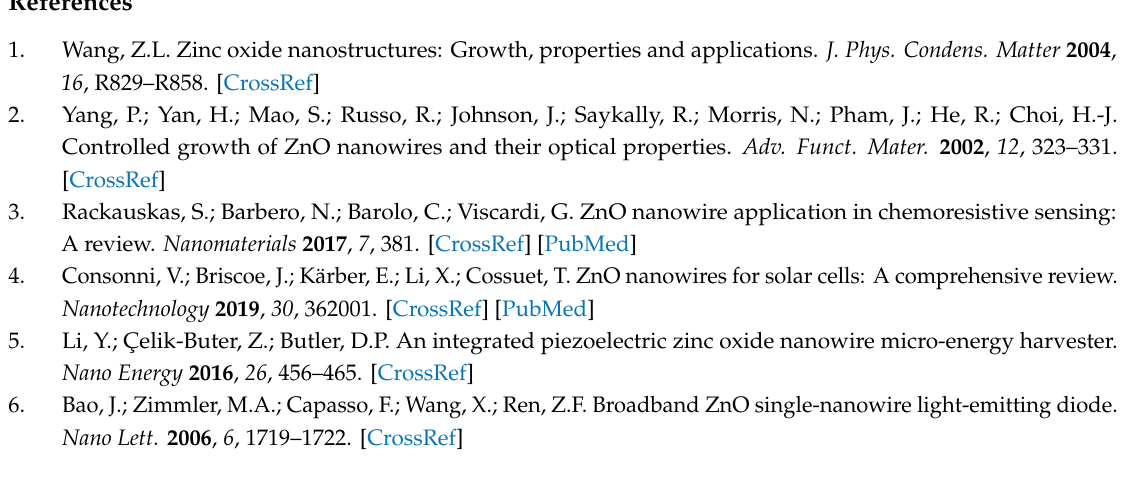
Figure S1: SEM and TEM characterizations of the as-grown ZnO nanowires, Figure S2: PL data of the as-grown ZnO